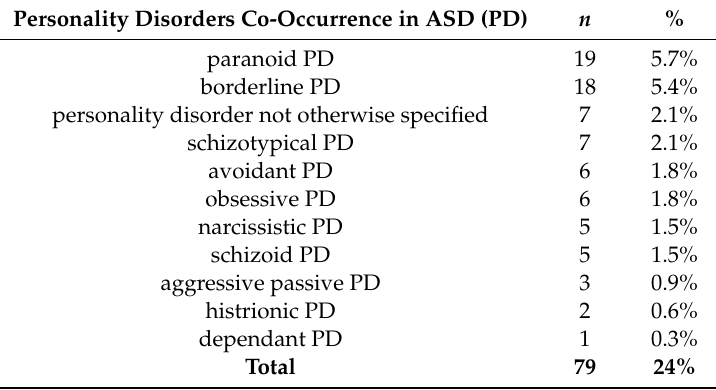
Table 3. Personality disorders in the study participants with autism.